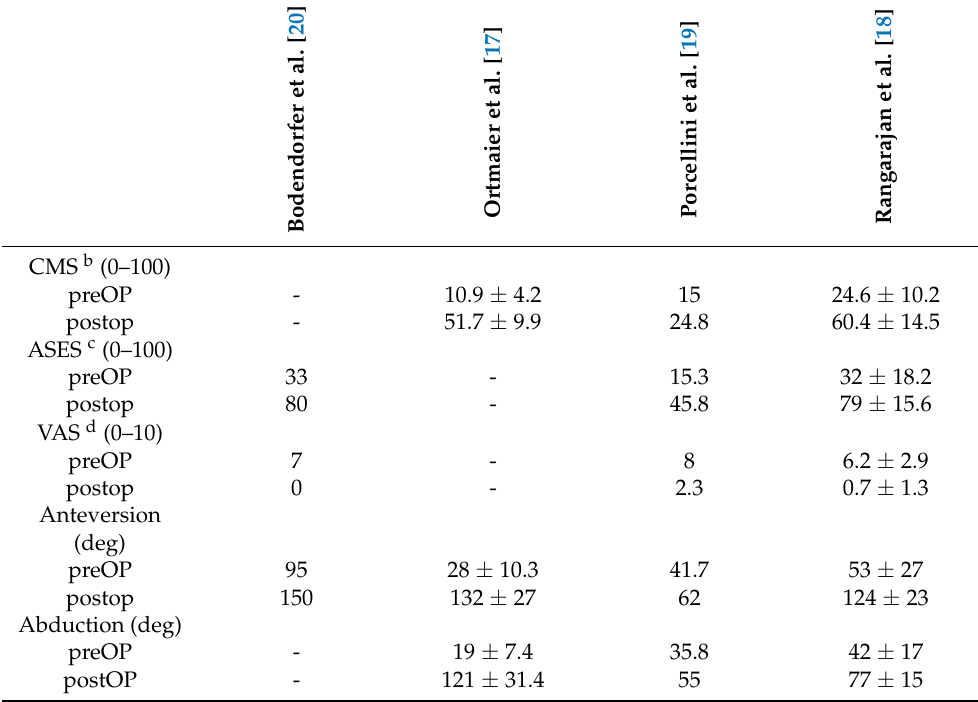
Table 2. Summary of the clinical data of the included literature a .